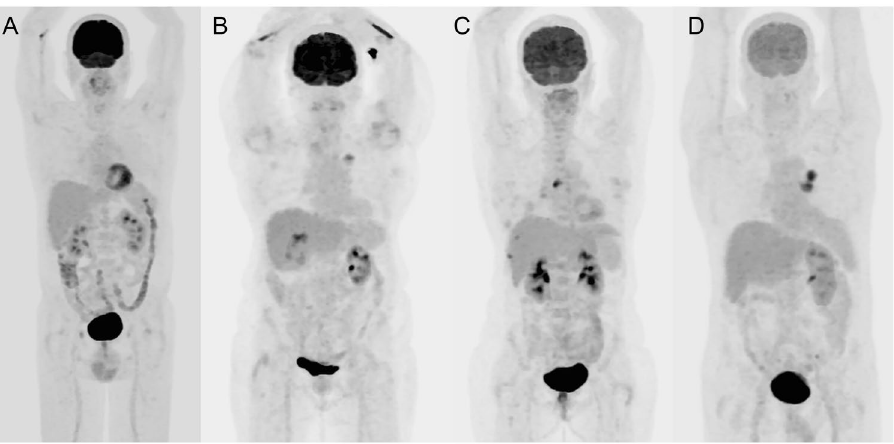
Figure 2. PET images of patients from different glycemia groups: ( A ) < 110 mg/dL; ( B ) 110–159 mg/dL; ( C ) 160–179 mg/dL; and ( D ) 180–199 mg/dL. Visual qualitative comparison demonstrates that 18 F-FDG uptake in the brain was markedly reduced for higher blood glucose levels, whereas no difference is apparent in the liver or